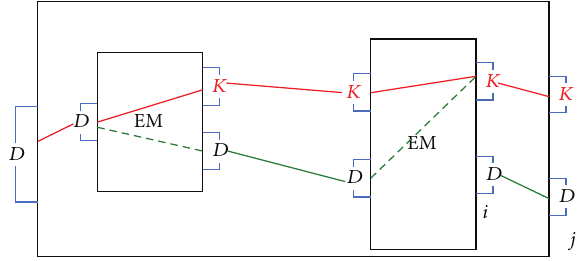
Figure 6: An Information Tracking composed by alternative Map- ping and Coupling .